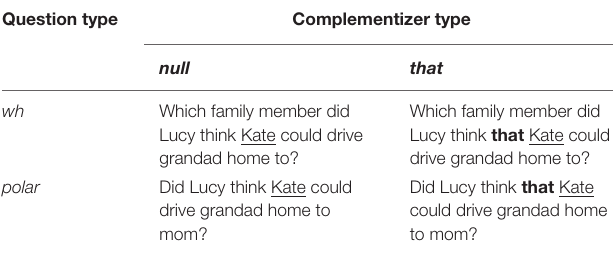
TABLE 1 | The four conditions used in the study: wh-null, polar-null, wh-that,